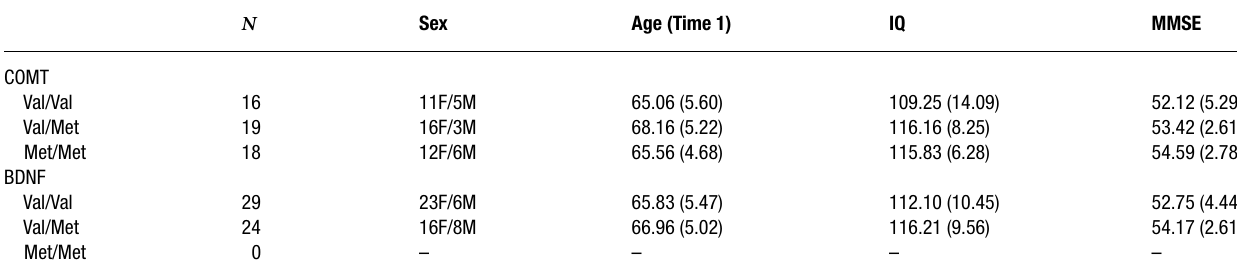
Table 1 | Demographic information, IQ, and MMSE scores are stratifi ed by both the COMT and BDNF polymorphism. N